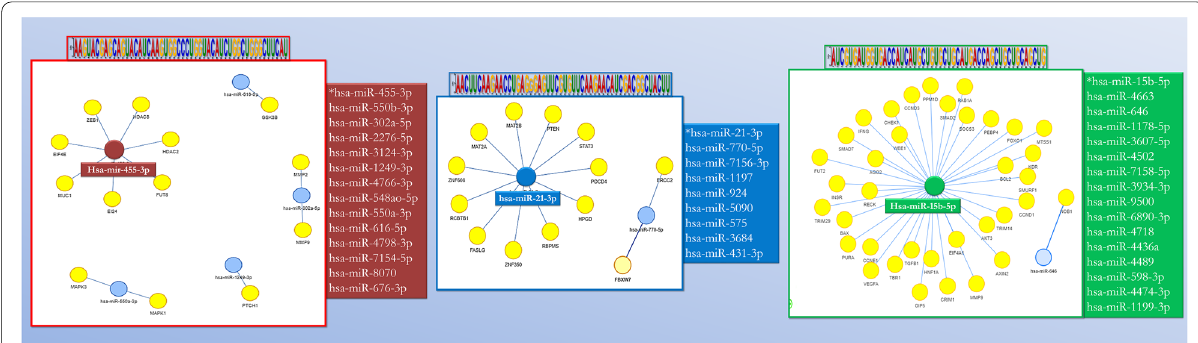
Fig. 4 The output of MIENTURNET. The miRNAs that are similar to each motif are separated into boxes. The three miRNAs identified by GeneCodis4 analysis are highlighted in the